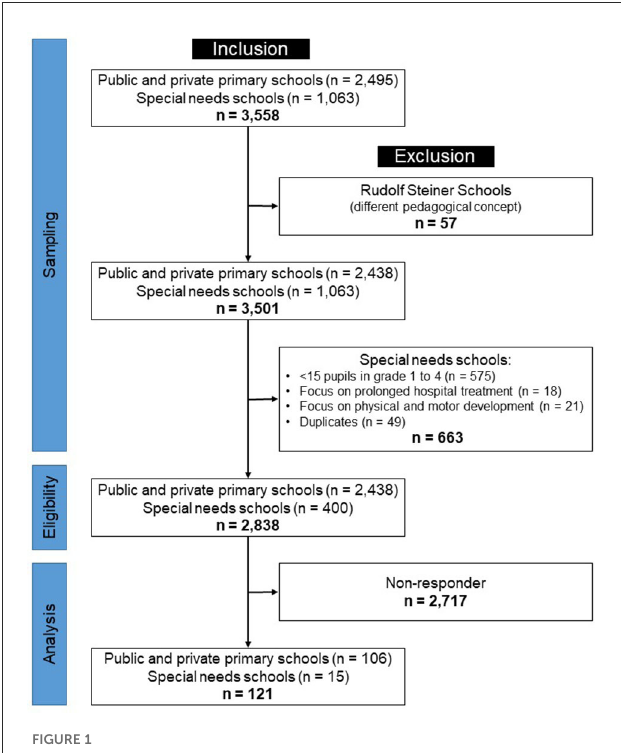
FIGURE1 Data sampling flow